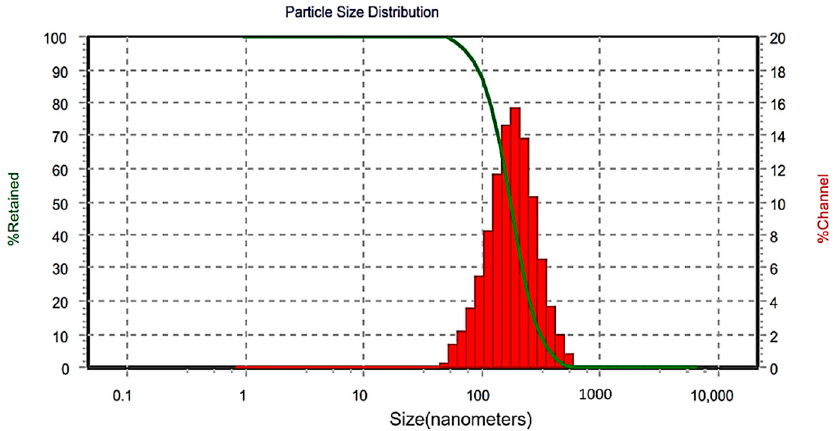
Figure 7. Size distribution of the nano ‐ emulsion ‐ based jelly formulation (NEJ ‐ 5) after reconstitution.